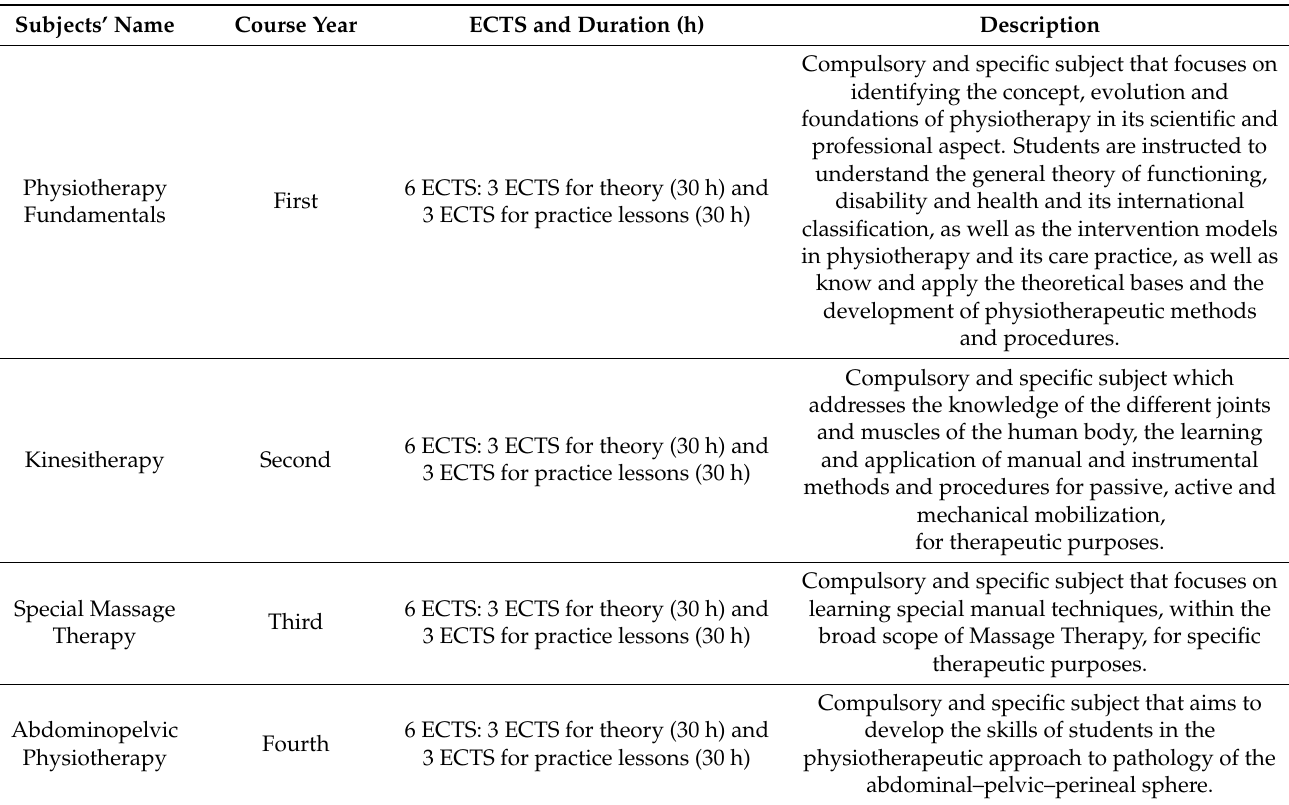
Table 1. Subjects of the Degree in Physiotherapy from University of Ja é n (Spain) participating in this research.